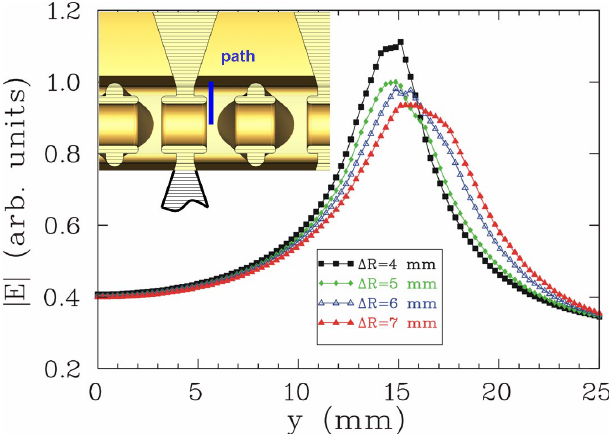
FIG. 9. (Color) Electric field along a path perpendicular to the beam axis for different drift-tube wall thicknesses (cid:2) R . The field is normalized to the maximum field for (cid:2) R (cid:1) 5 mm (prototype geometry). The path distance from the tube ends is 2 mm in all cases. The aperture diameter is 25 mm in all cases, the g=L ratio is 0.5, L (cid:1) 42 : 6 mm .